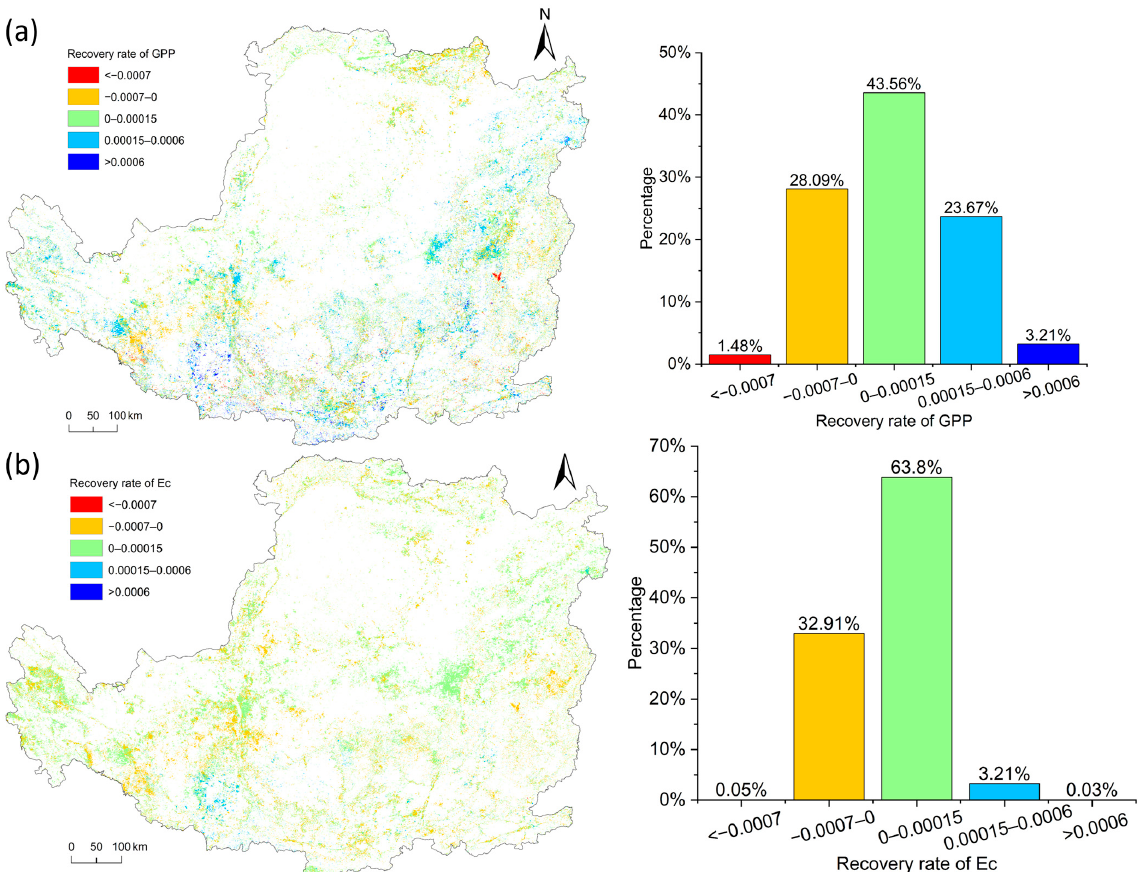
Figure 5. Spatial distribution of the recovery rate and the percentage of different intervals of the recovery rate: ( a ) GPP; ( b ) Ec.